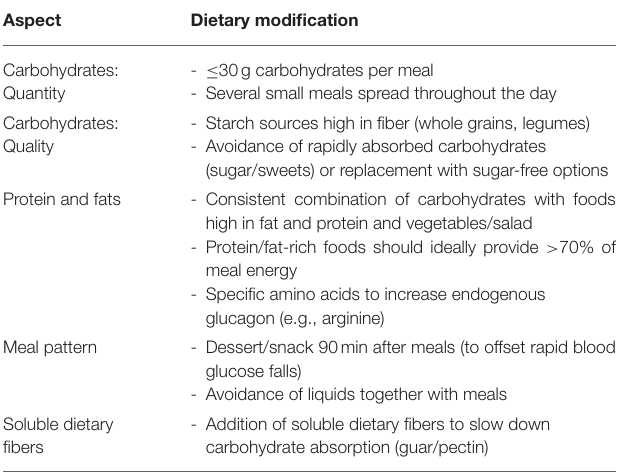
TABLE 1 | Dietary modifications for the management of postbariatric hypoglycemia.